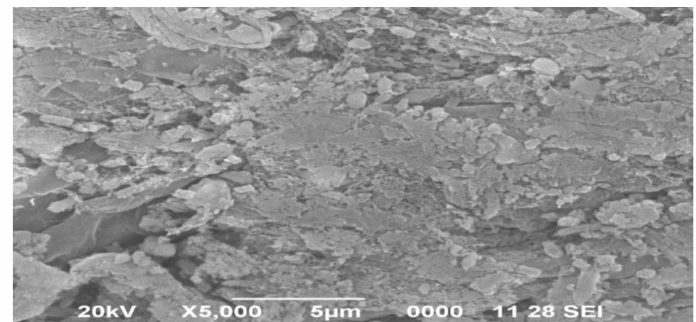
Figure 8. SEM analysis of mucilage in × 5000.